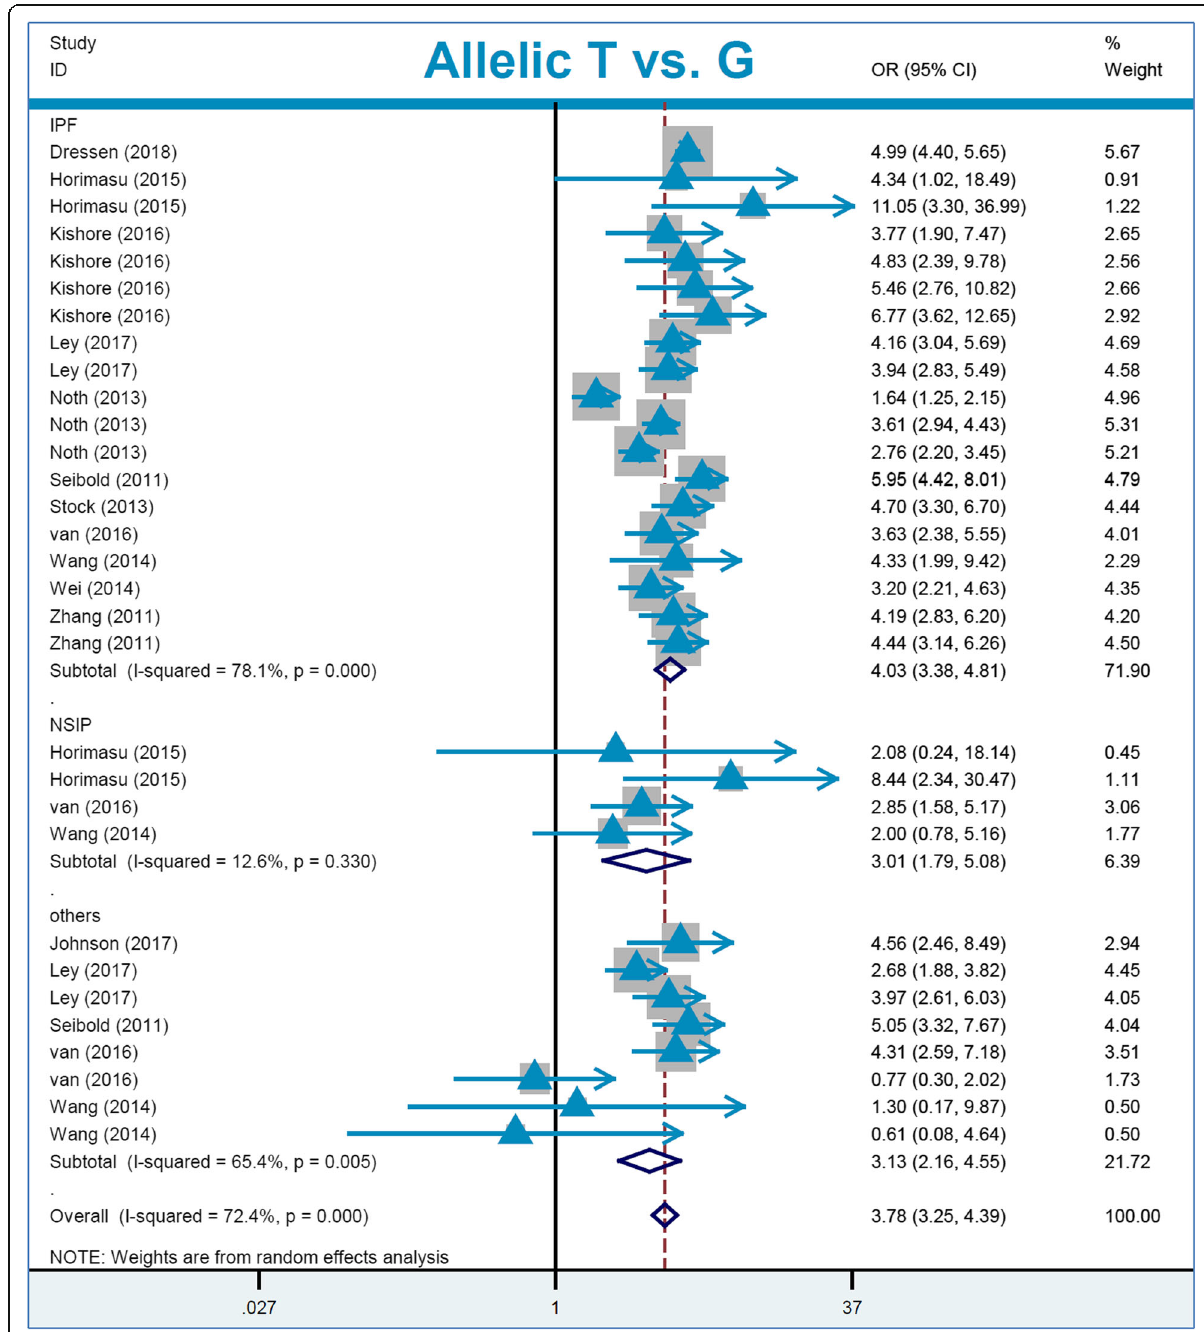
Fig. 4 Subgroup analysis of “ pneumonia type ” for MUC5B rs35705950 under the allelic